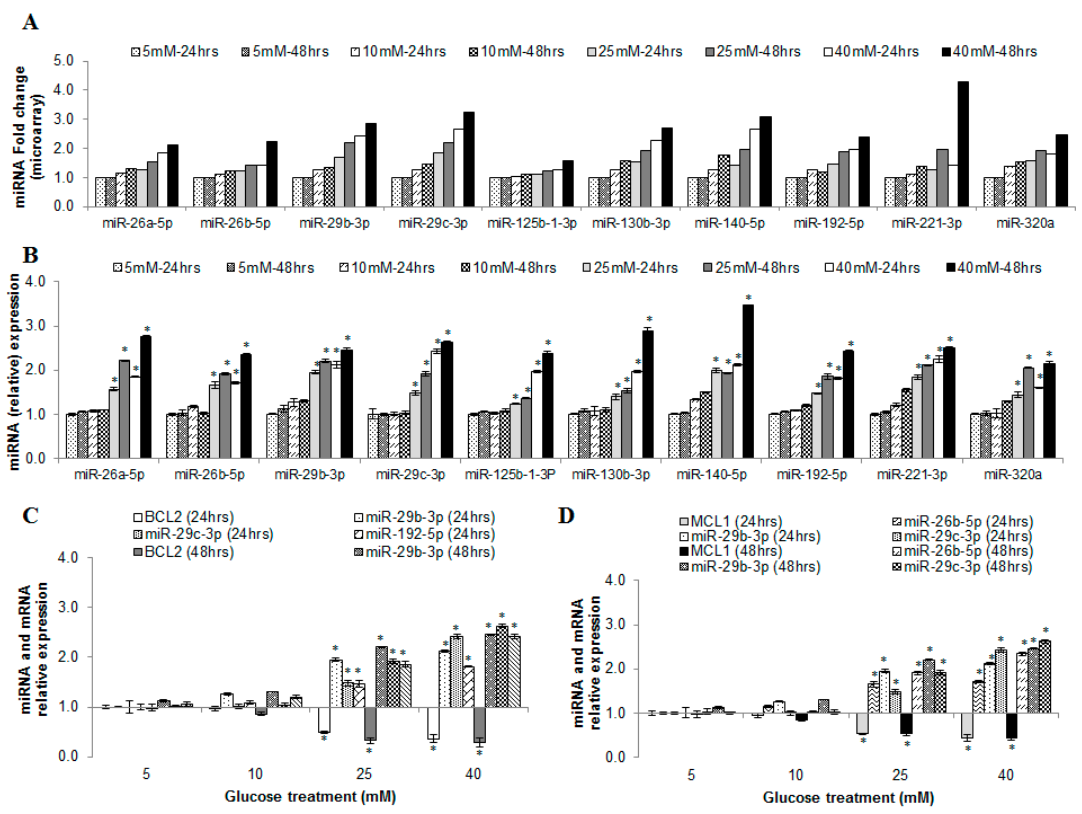
Figure 4. Validation of selected miRNAs and target mRNAs using qPCR. ( A ) Represents the pattern of expression observed for the 10 selected miRNAs from the microarray data for HUVECs treated with different glucose treatments for 24 and 48 h; ( B ) Verification of microarray data in ( A ) by real-time quantitative PCR; ( C , D ) The expression level of three miRNAs and their corresponding mRNAs that are involved in apoptosis: ( C ) miR-29b-2p and -192-5p against BCL2 mRNA and ( D ) miR-26b-5p and -29b-3p against MCL-1 mRNA. Data are presented as mean ± SEM ( n = 3). * indicates statistical significance at p < 0.05 using t-test against control (test vs. 5 mM glucose treatment).